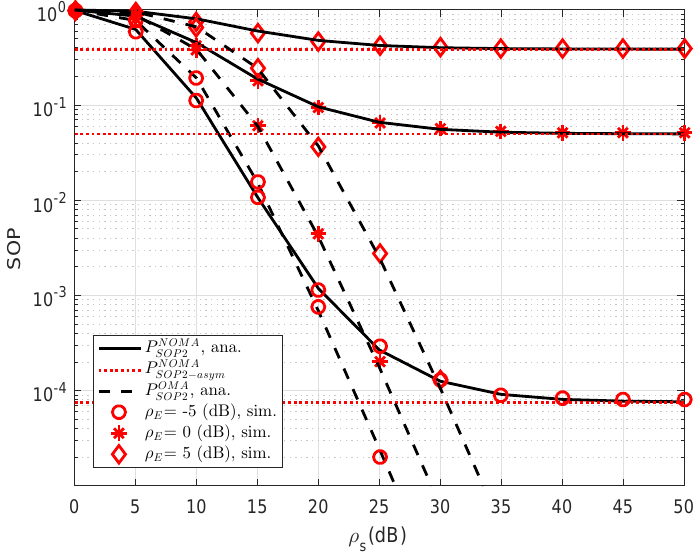
Figure 7. Comparison study of SOP for NOMA and OMA for User D2 versus ρ S = ρ R as varying ρ E